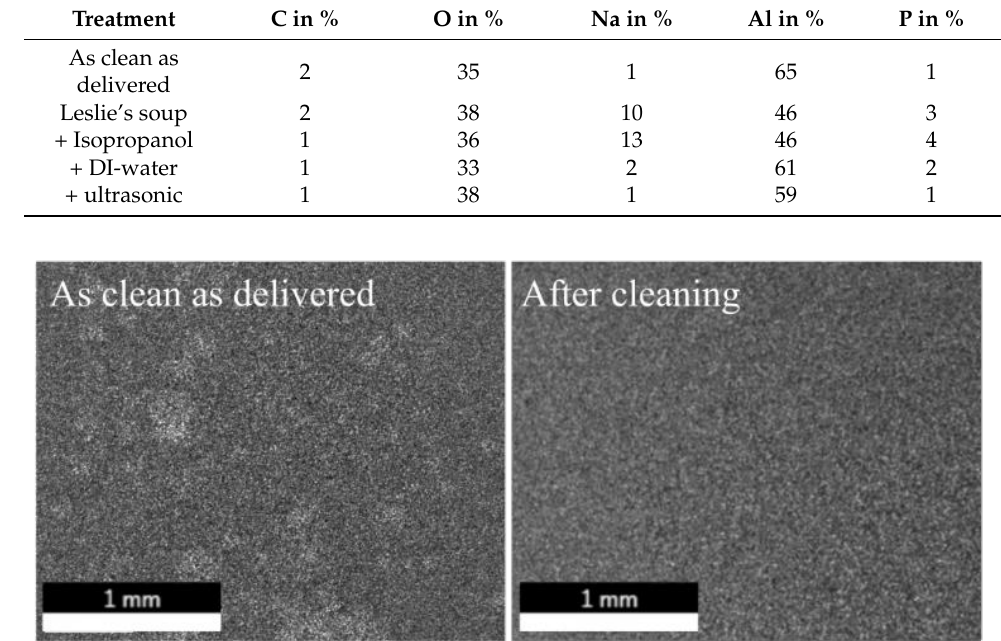
Figure 4. Comparison of the surfaces of an “as clean as delivered” ceramic substrate and after performing the cleaning procedure.